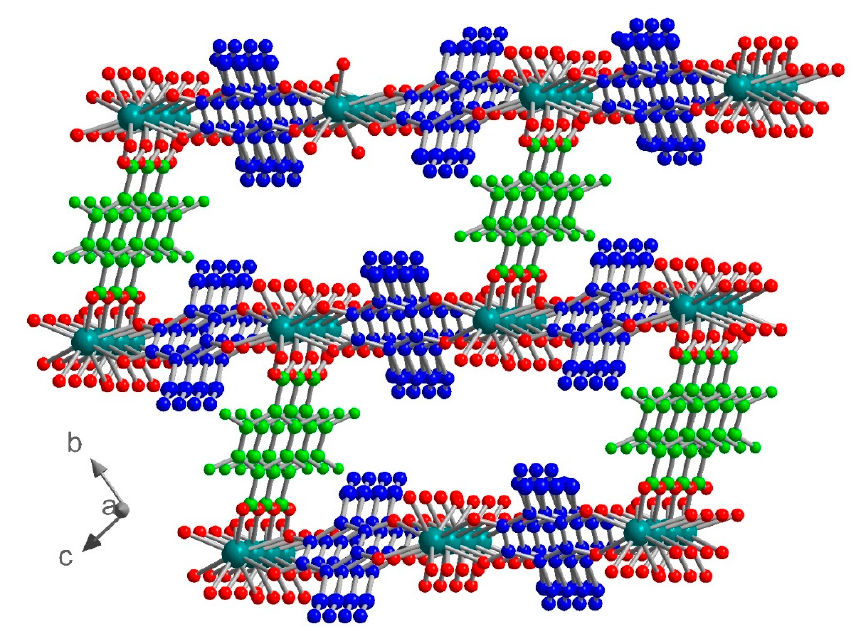
Figure 3. View of the crystal structure in 1 showing the rectangular cavities along the a axis. ClCNAn 2 − and F 4 BDC 2 − are highlighted in blue and green, respectively.